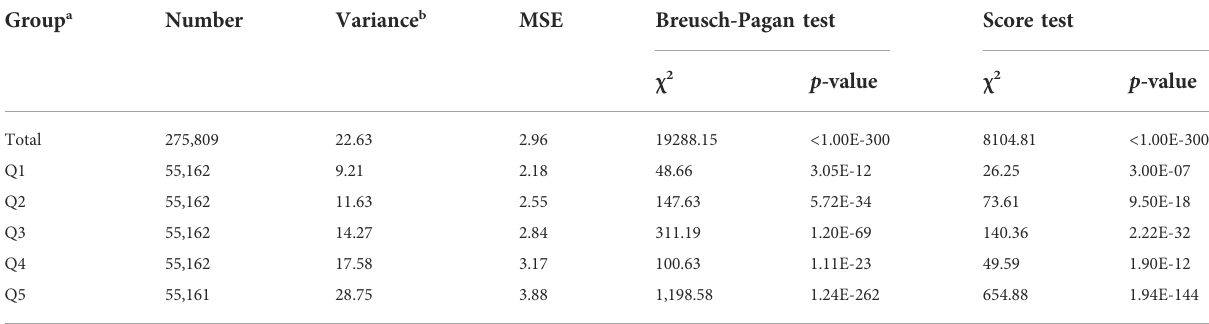
TABLE 3 The heteroscedasticity of BMI according to GPS quintile.